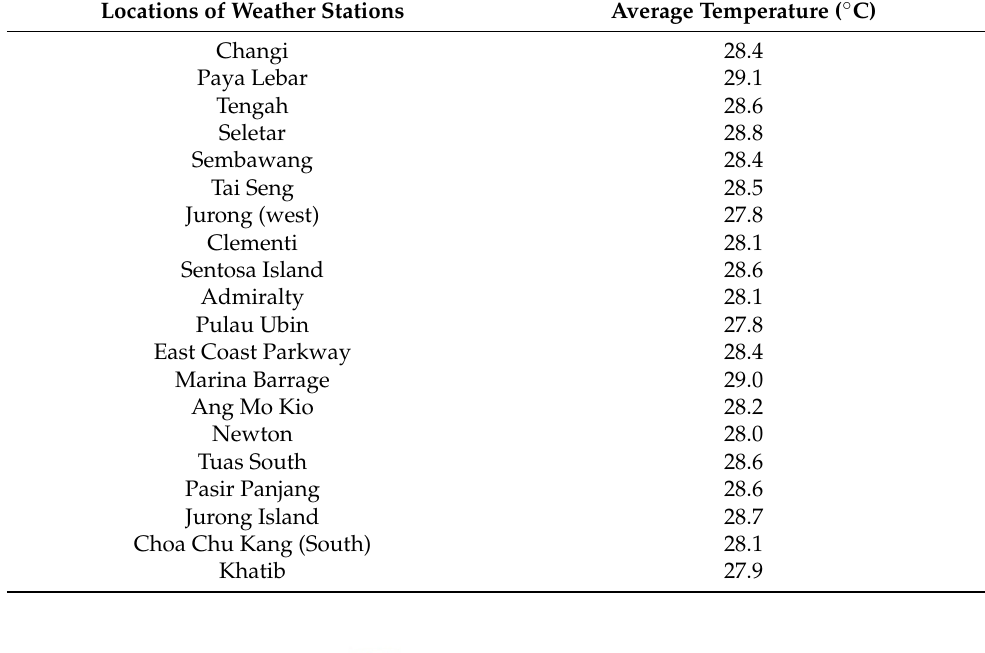
Table 3. Comparison of 2019 average temperature data across Singapore [79].